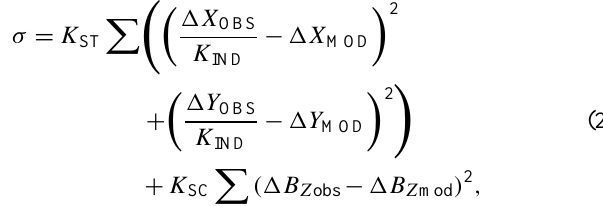
Fig. 8a. The mapping from a fixed neutral sheet